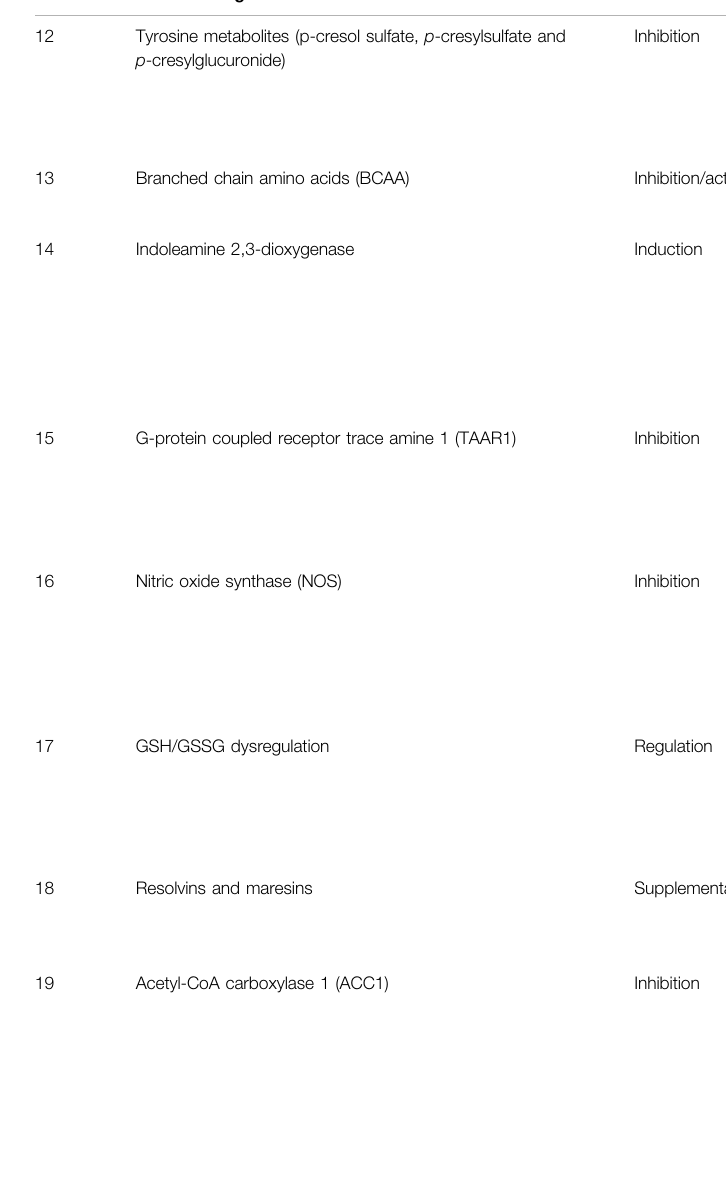
phenylalanine and tyrosine metabolites derived from the gut microbial fl ora were increased in patients with cGVHD compared to controls and shown association with in fl